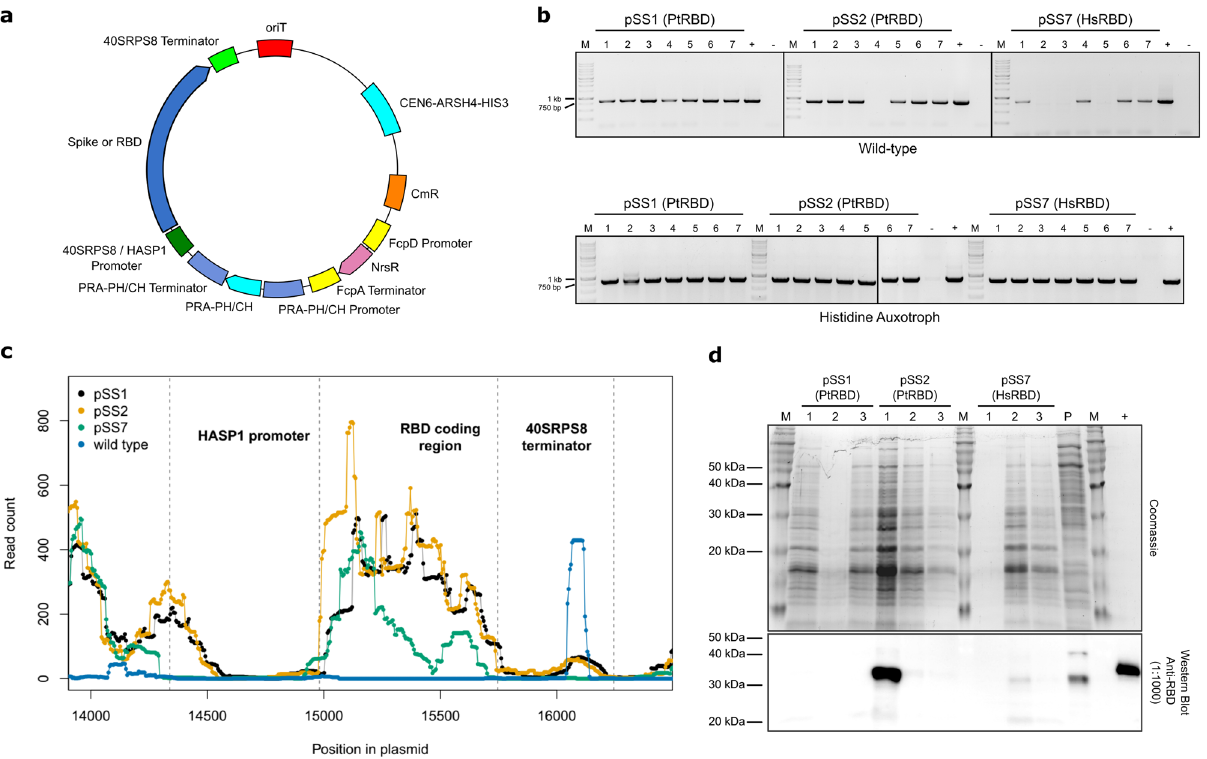
Figure 1. Expression of SARS-CoV-2 RBD from stably maintained plasmids in P. tricornutum . ( a ) Schematic of expression plasmids used in this study. oriT, conjugative origin of transfer; CEN6-ARSH4-HIS3, yeast replication origin and selective marker; CmR, chloramphenicol resistance gene; FcpD, promoter and terminator elements derived from the FcpD gene 33 ; NrsR, nourseothricin resistance gene; PRA-PH/CH, promoter, coding region and terminator from the PRA-PH/CH gene (histidine biosynthesis); 40SRPS8/HASP1 promoter, promoter elements from the 40SRPS8/HASP1 promoter; 40SRPS8 terminator, terminator derived from the 40SRPS8 gene. ( b ) Stability of the RBD coding region assessed using PCR with RBD-specific primers in plasmids from wild-type (top) or histidine auxotroph (bottom) P. tricornutum clones. Numbers indicate individual plasmids isolated from P. tricornutum clones. The expected product is 833 bp. PtRBD, codon- optimized for P. tricornutum ; HsRBD, codon-optimized for HEK293 cells; M, 1-kb DNA ladder. ( c ) Plot of RNAseq reads mapped to the pSS1 plasmid sequence for wild-type P. tricornutum (WT) and P. tricornutum harbouring pSS1, pSS2, or pSS7. ( d ) Coomassie-stained gel (top) and western blot (bottom) of whole cell lysates from 3 histidine auxotroph clones harbouring pSS1, pSS2 or pSS7, and from a pool of clones harbouring pSS1 (P). M, PiNK Plus Prestained Protein Ladder. +, 5 ng of commercially available RBD purified from HEK293 cells. Uncropped gel images for panels ( c ) and ( d ) are shown in Supplementary Figures